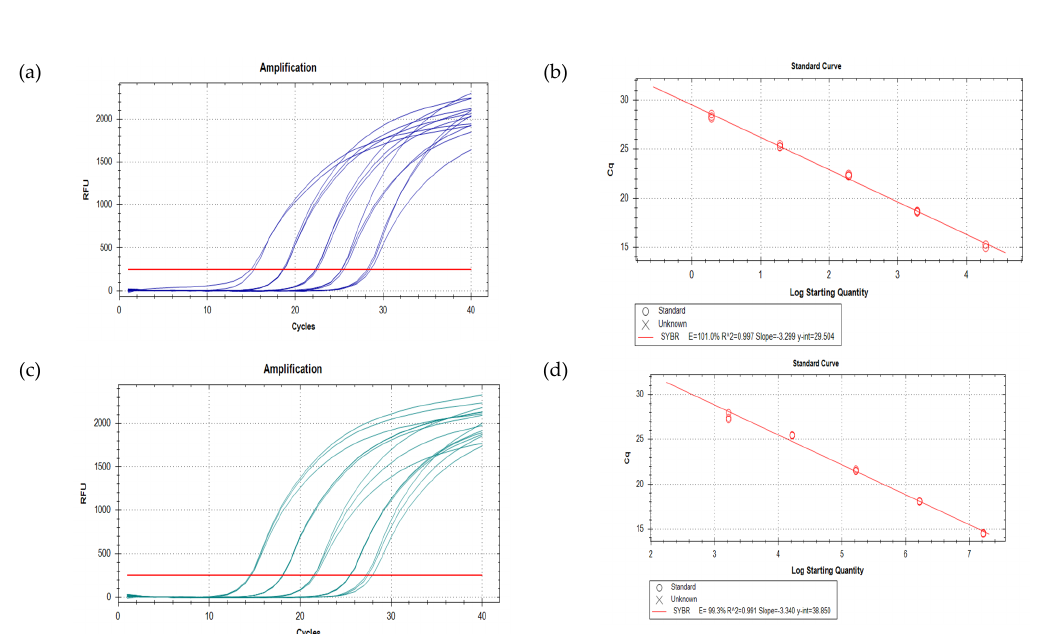
Figure 2. ( a ) Amplification plot showing dilution series using P. minimum culture DNA using primer set 20 and ( b ) DNA standard curve with R 2 value = 0.997 and E = 101%. ( c ) Amplification plot showing dilution series using P. minimum gBlocks using primer set 20 and ( d ) gBlock standard curve with R 2 value = 0.991 and E = 99.3%.